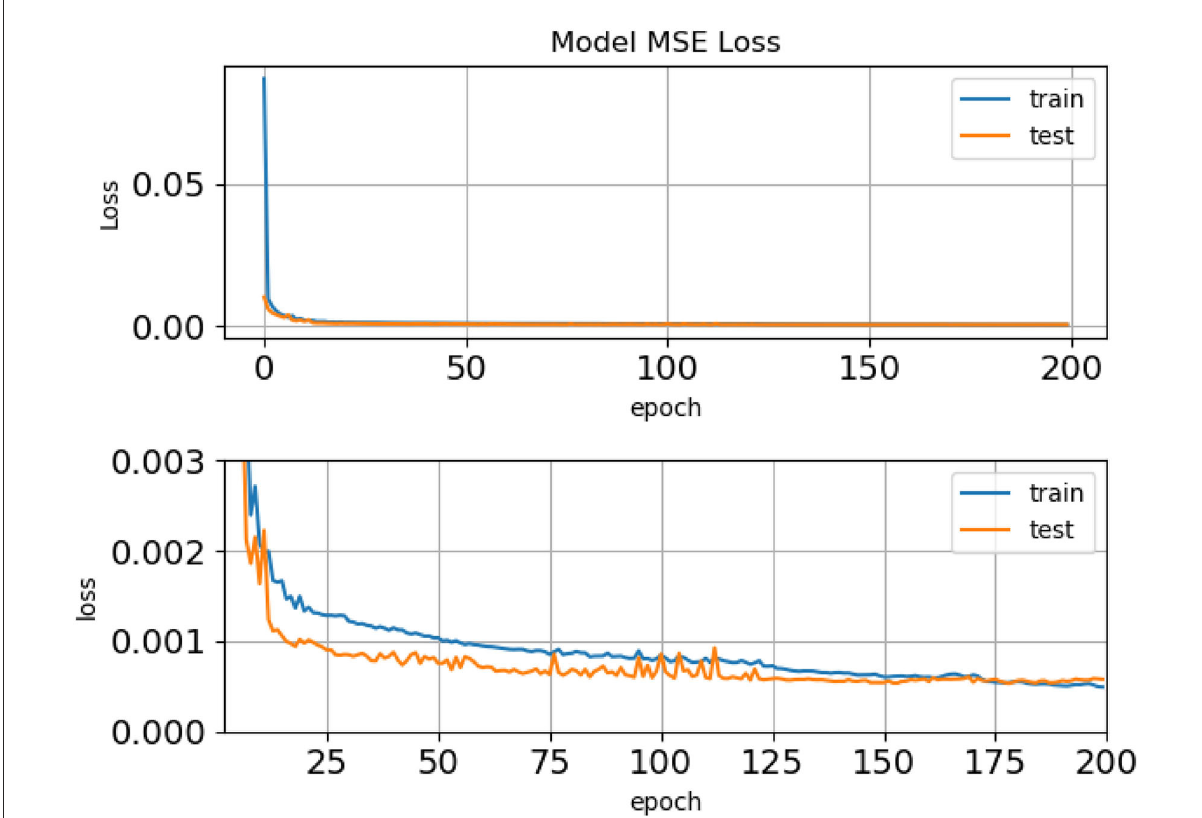
FIGURE3 The mean square error (MSE) error calculated from a comparison of the model predictions with the training (train) and the validation (test) data sets over a 200 epoch training period. We see a rapid convergence of the model on the minimum MSE value. The upper panel shows the MSE values over the full 200 epochs. In order to show greater detail of the model fitting process, the lower panel shows the same MSE values at higher resolution and focused on the tail of the model training. Note the different y-axis scales between the two